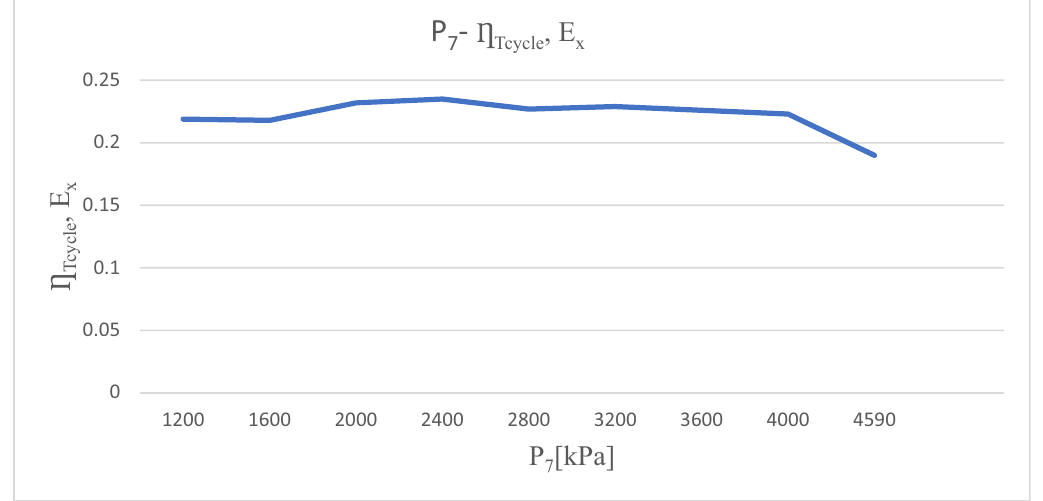
Figure 5: Exergy e ffi ciency curves of the whole cycle obtained for di ff erent outlet pressures at which the fi rst - stage compressor of the vapor compression two - stage cascade cryogenic cycle can operate.